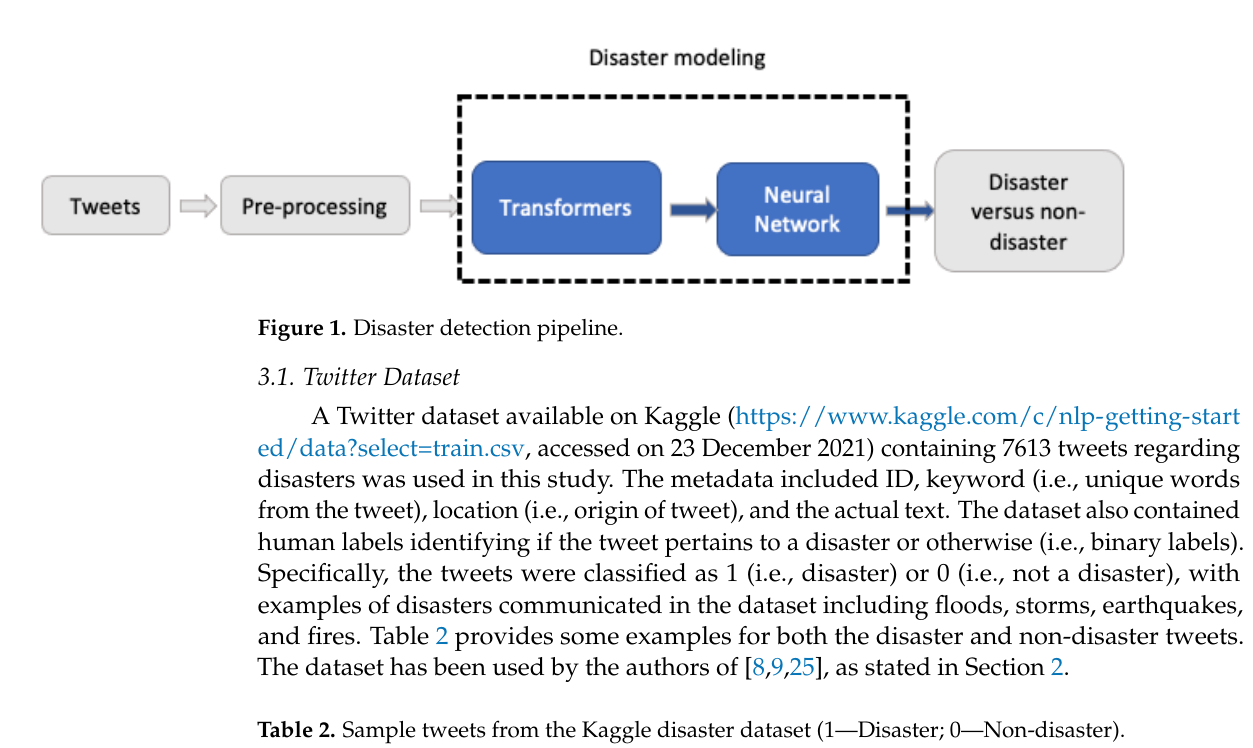
Original Tweets